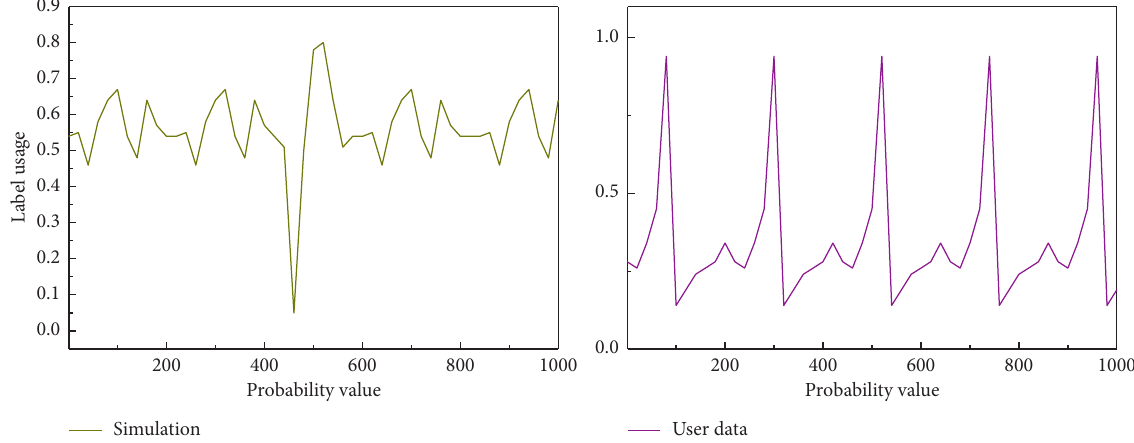
Figure 8: Distribution of dataset label usage. Table 1: Recall of all